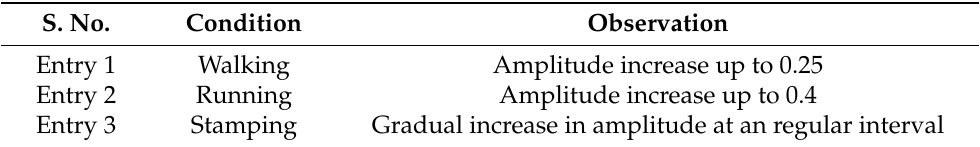
Figure 15. Signal while tapping. Table 4. Observation of amplitude for signal.